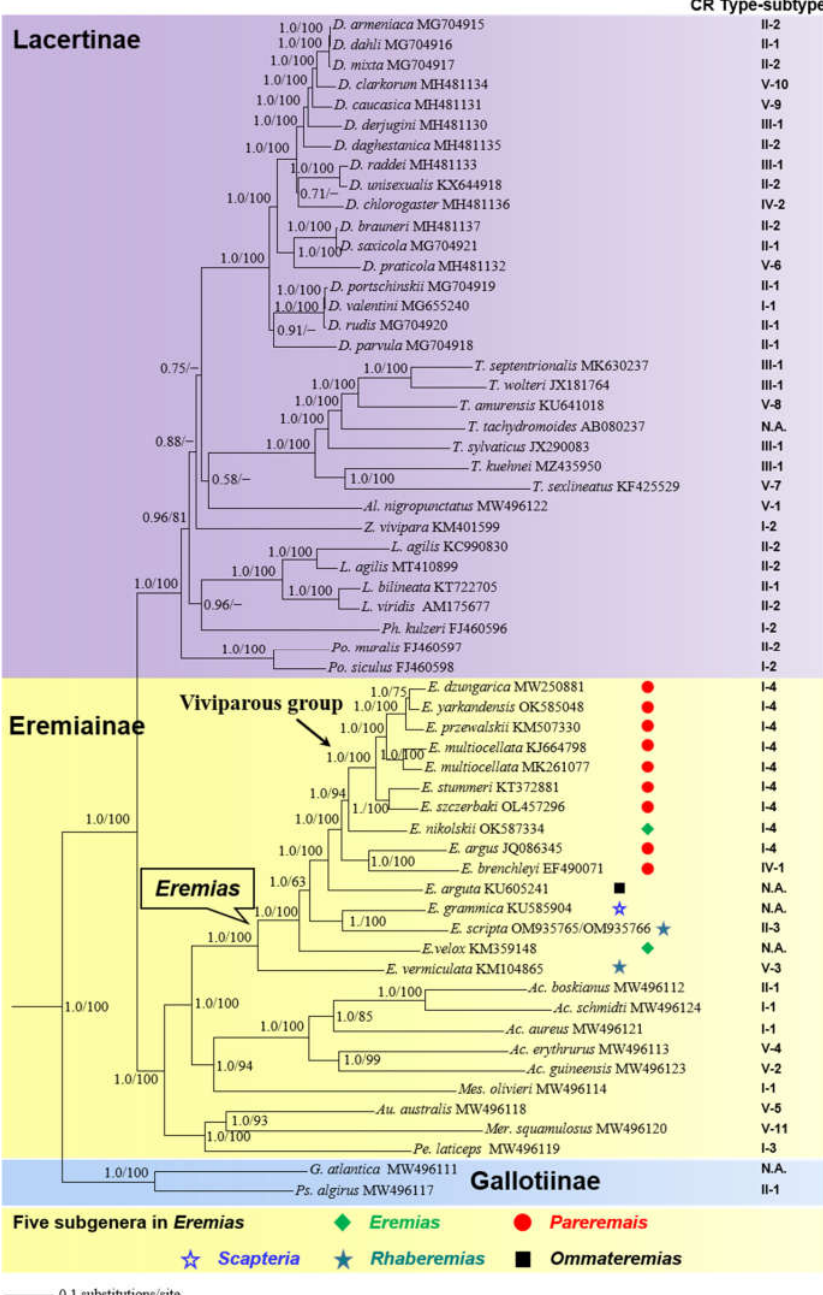
Figure 7. A 50% majority-rule consensus tree of the family Lacertidae inferred from partitioned Bayesian analyses based on the concatenated PCGs of 58 lacertids and 3 outgroup taxa (not shown for clarity). Node numbers indicate Bayesian posterior probabilities (PP) and ML ultrafast bootstrap values (UFBoot), respectively. Dashes represent nodes with bootstrap support lower than 50% or represent nodes that do not exist in ML tree. Branch lengths represent means of the posterior distribution. GenBank accession numbers are given with species names, and subfamily assignments are listed, along with the viviparous group/subgenera in Eremias . Types/subtypes of the CR are mapped on the tree and correspond to those depicted in Figure 6. N.A., not applicable, for species with incomplete CR available in